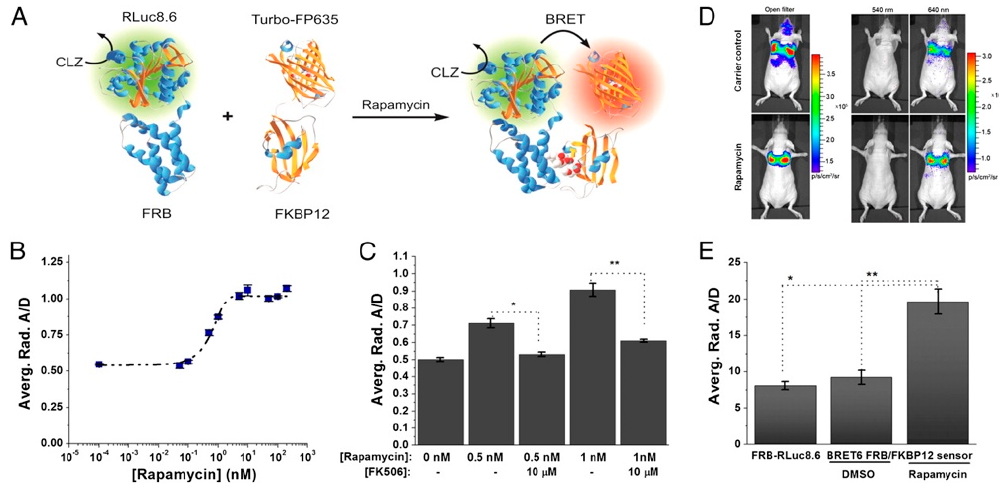
Figure 11. BRET sensor for protein–protein interactions in the lungs of mice. ( A ) Schematic of the BRET system. The proteins FRB and FKBP12 form a heterodimer upon addition of the small molecule rapamycin. As the FRB and FKB12 used are chimeras with the luciferase RLuc8.6 and the fluorescent protein Turbo-FP635, respectively, the dimerization brings the BRET donor and acceptor into close proximity, facilitating energy transfer. ( B ) Dose–response curve of 1 × 10 5 HT1080 cells expressing the BRET-CID system 6 h after addition of rapamycin with an estimated EC 50 of 0.7 ± 0.2 nM. ( C ) Influence of the inhibitor FK506 on the BRET ratios demonstrating the specificity of the BRET6 sensor. ( D ) Bioluminescence images of control (top) and rapamycin-dosed mice (bottom) after CLZ injection using open, donor, and acceptor filters. ( E ) Comparison of the BRET-ratios of control groups, which include the BRET donor only (FRB-RLuc8.6) and the donor–acceptor pair in the absence of the CID-inducer (BRET6 FRB/FKBP12 sensor, DMSO), with the BRET donor–acceptor pair in the presence of the CID-inducer (BRET6 FRB/FKBP12 sensor, rapamycin) [146]. Copyright 2011 Dragulescu-Andrasi et al.